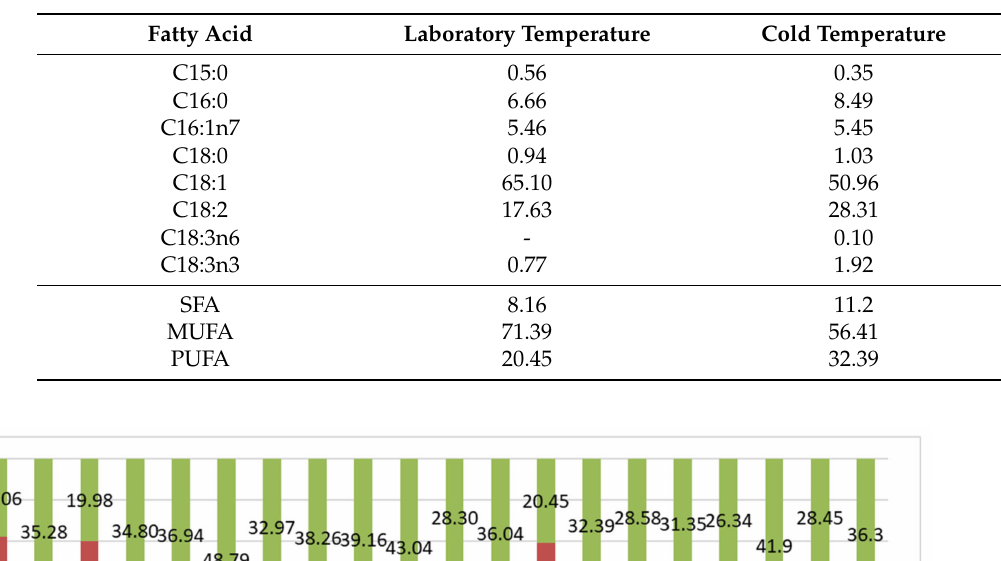
Table 4. Selected fatty acid profile (%) of lipid content produced by Metschnikowia andauensis 1241 cultivated on optimal glucose medium.